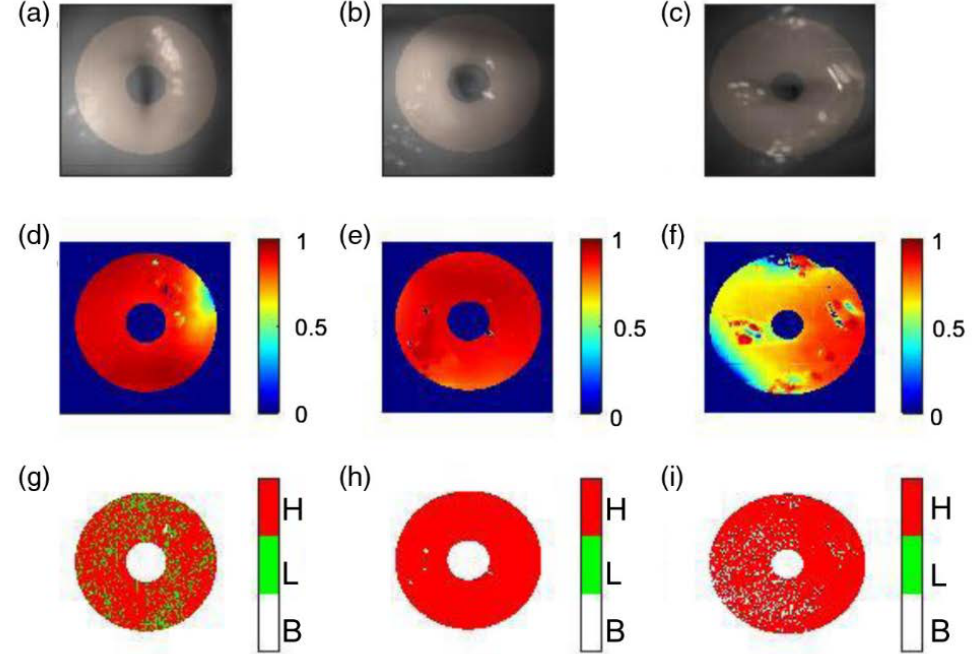
Figure 9. Cervical images taken by the snapshot Mueller matrix polarimeter, showing the ( a – c ) raw images and polarization information of ( d – f ) depolarization and ( g – i ) retardance (Reprinted from Ref. [56]).